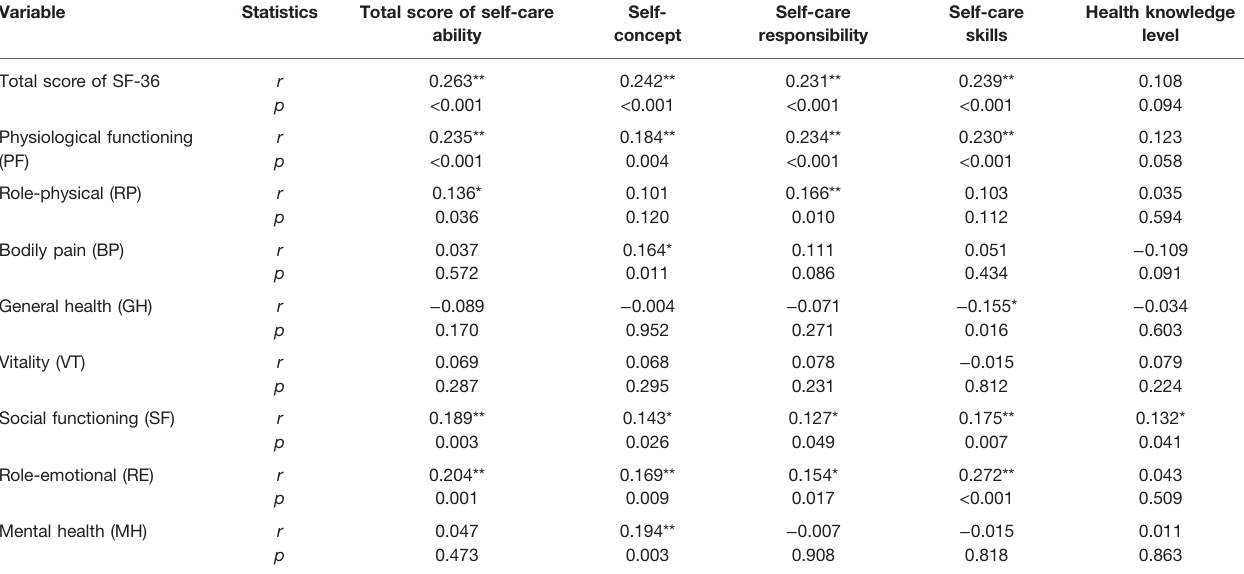
TABLE 3 | Correlation between self-care ability and quality of life in discharged patients with hepatolithiasis and diabetes mellitus with T-tube ( n =240). Variable